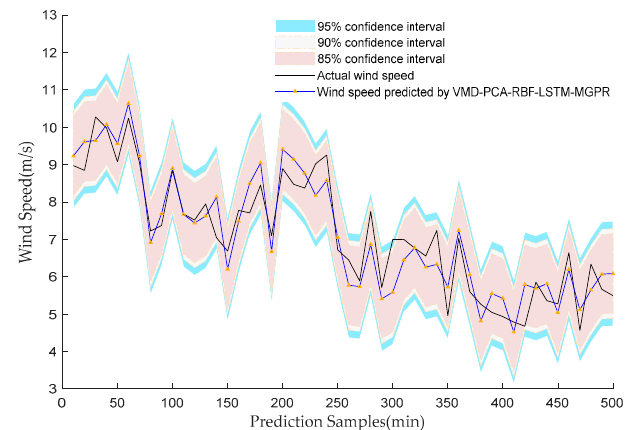
Energies 2020 , 13 , x FOR PEER REVIEW Figure 18. Interval prediction results of VMD-PRBF-LSTM-MGPR. Figure 18. Interval prediction results of VMD-PRBF-LSTM-MGPR.